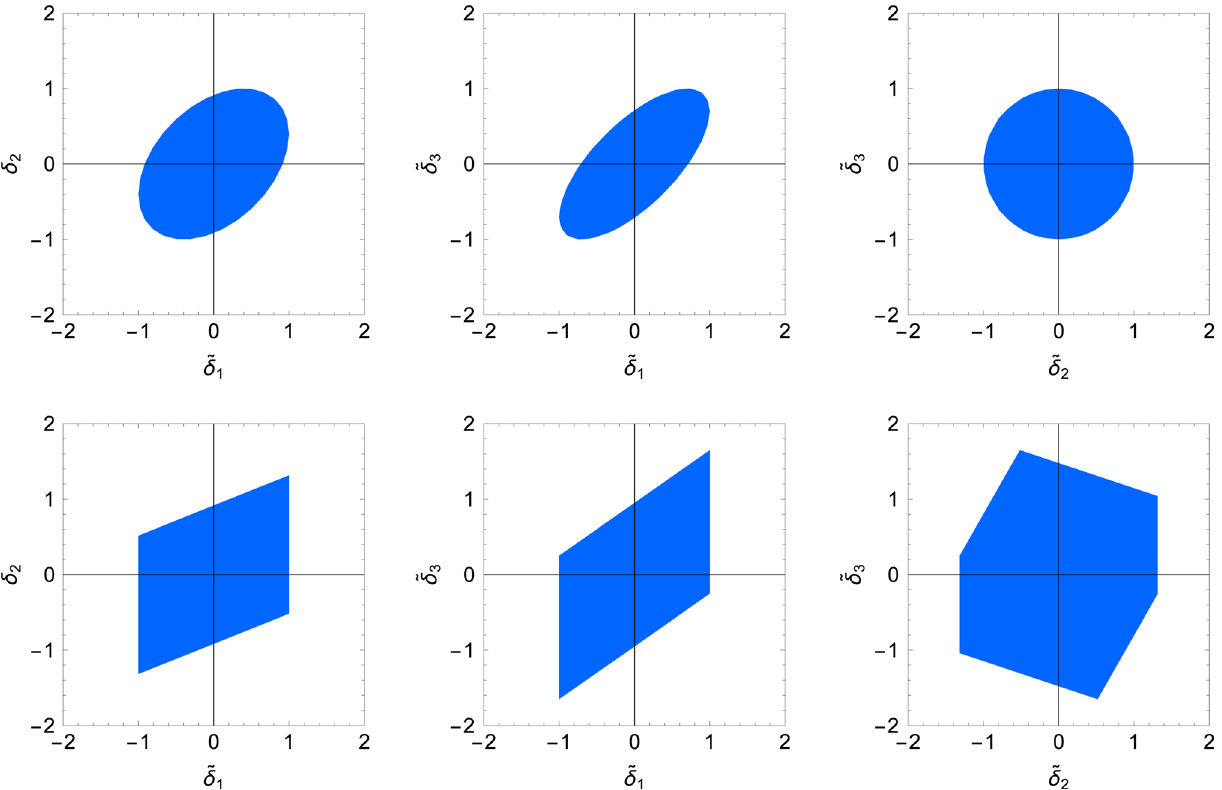
Fig. 11 Ranges of variation for ˜ δ 1 , ˜ δ 2 , ˜ δ 3 with ρ 12 = 0 . 4 ,ρ 13 = 0 . 7 ,ρ 23 = 0. The variation over a hyperball ( top ) or a hypercube ( bottom ) with correlations is considered. Neglecting correlations would yield discs ( top ) and squares ( bottom )